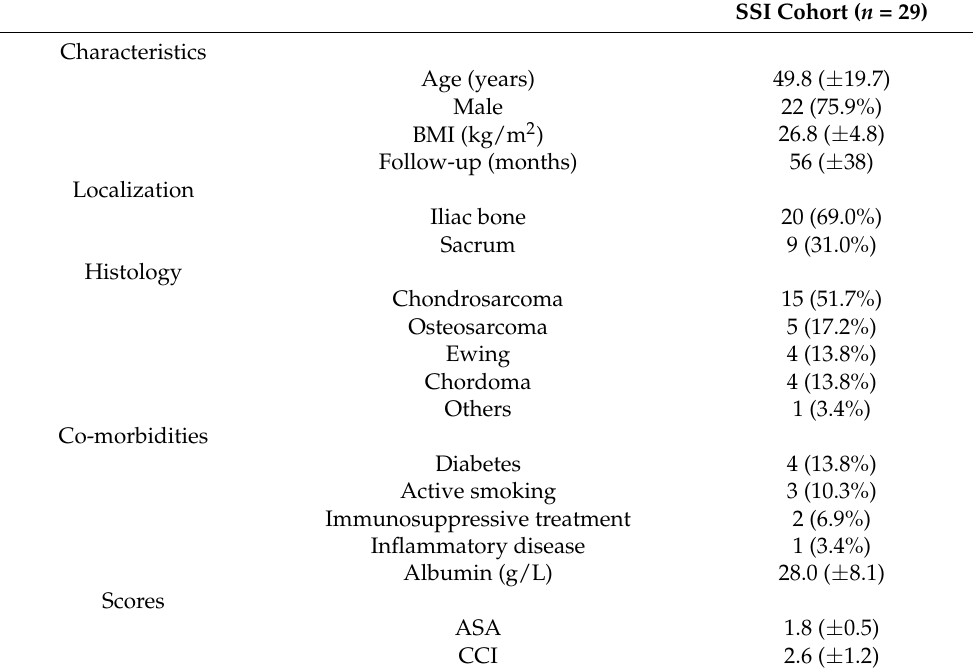
Table 1. Demographic data for the SSI cohort.